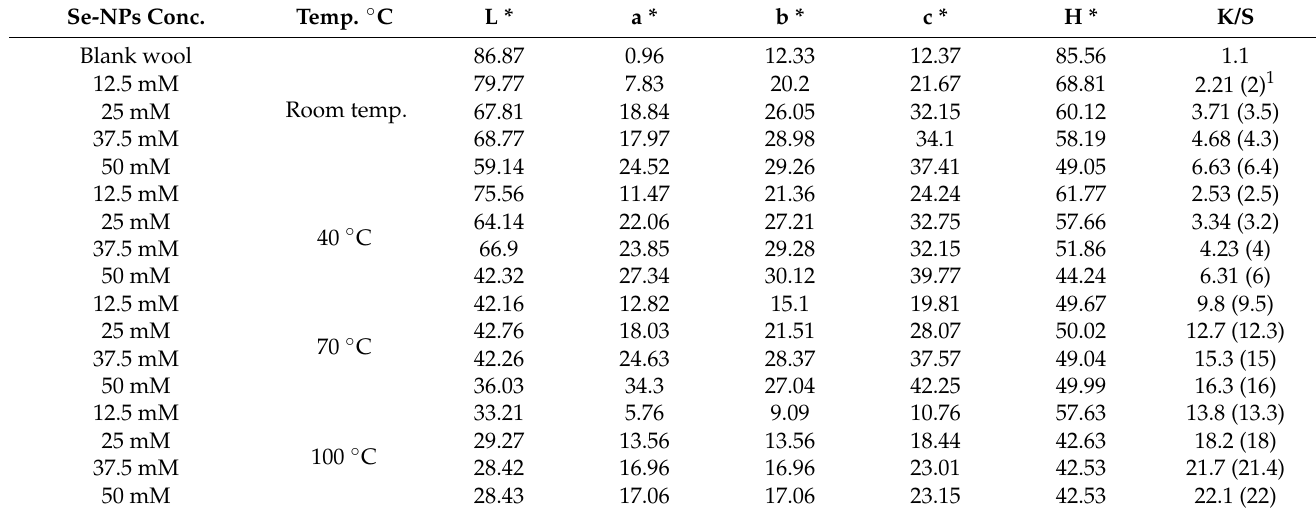
Table 3. Color characteristics for Se-dyed wool fabrics at different temperatures. Se-NPs